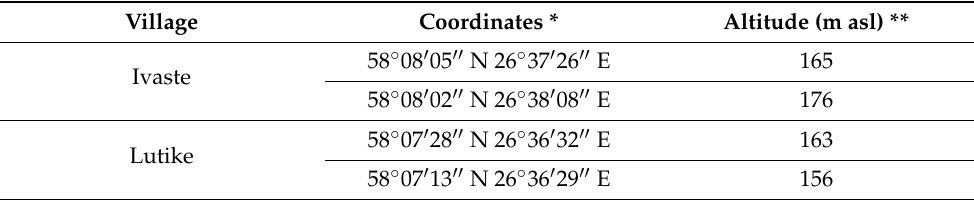
Table 1. Location of the study areas (forest clearcuts) in